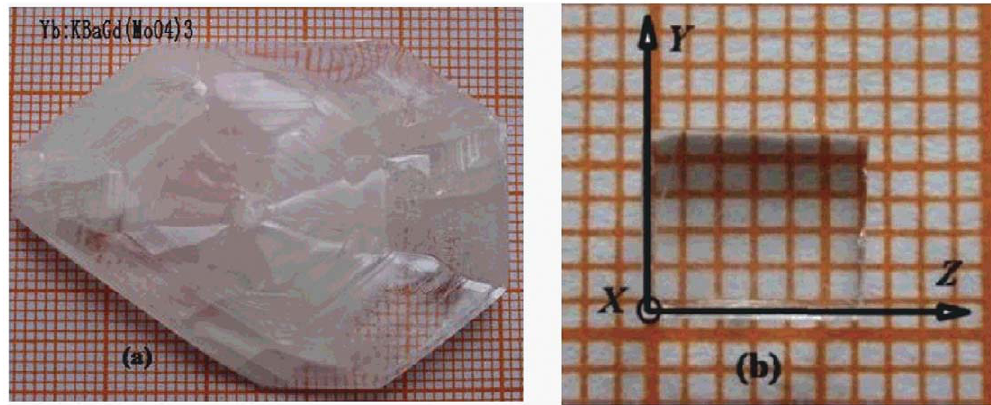
Figure 1. Picture of (a) Yb 3 + :KBaGd(MoO 4 ) 3 crystal, (b) polished sample cut from the crystal.